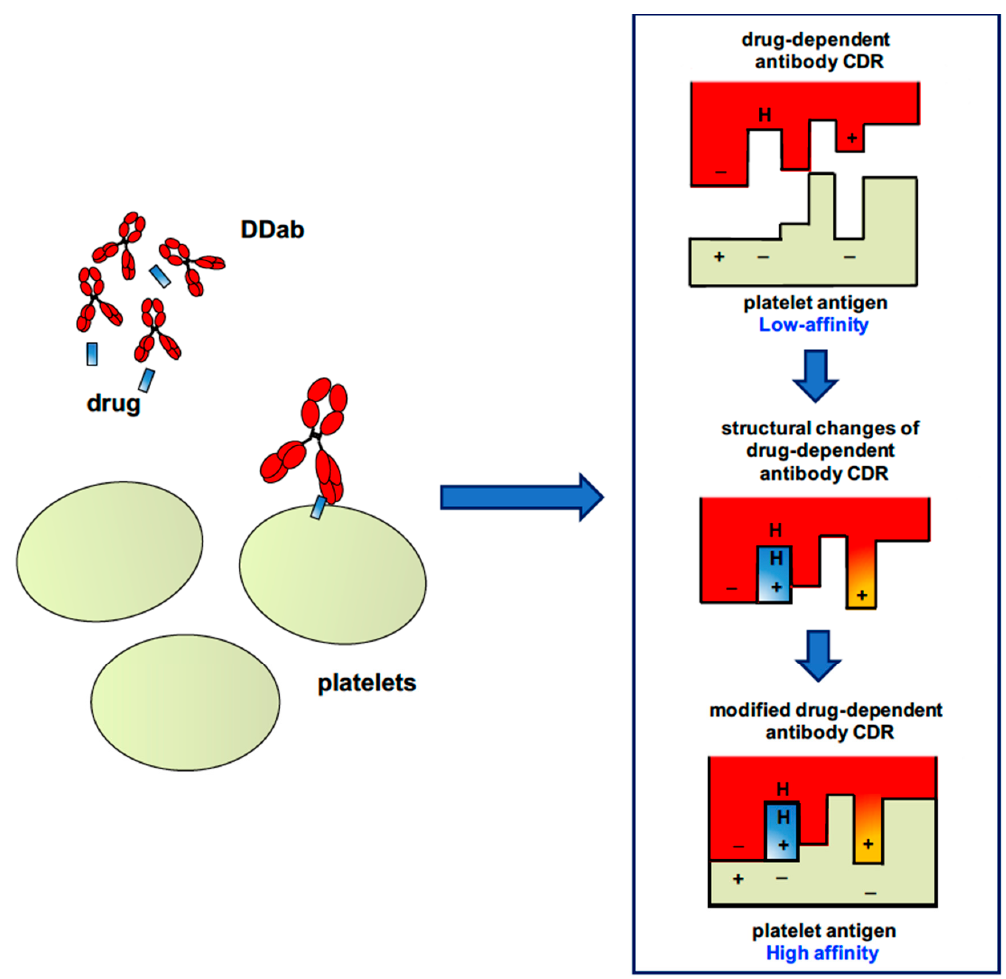
Figure 1. Schematic representation of the binding of a “quinine-type” drug-dependent antibody to a platelet glycoprotein. CDR, complementary-determining region; DDab, drug-dependent antibody.